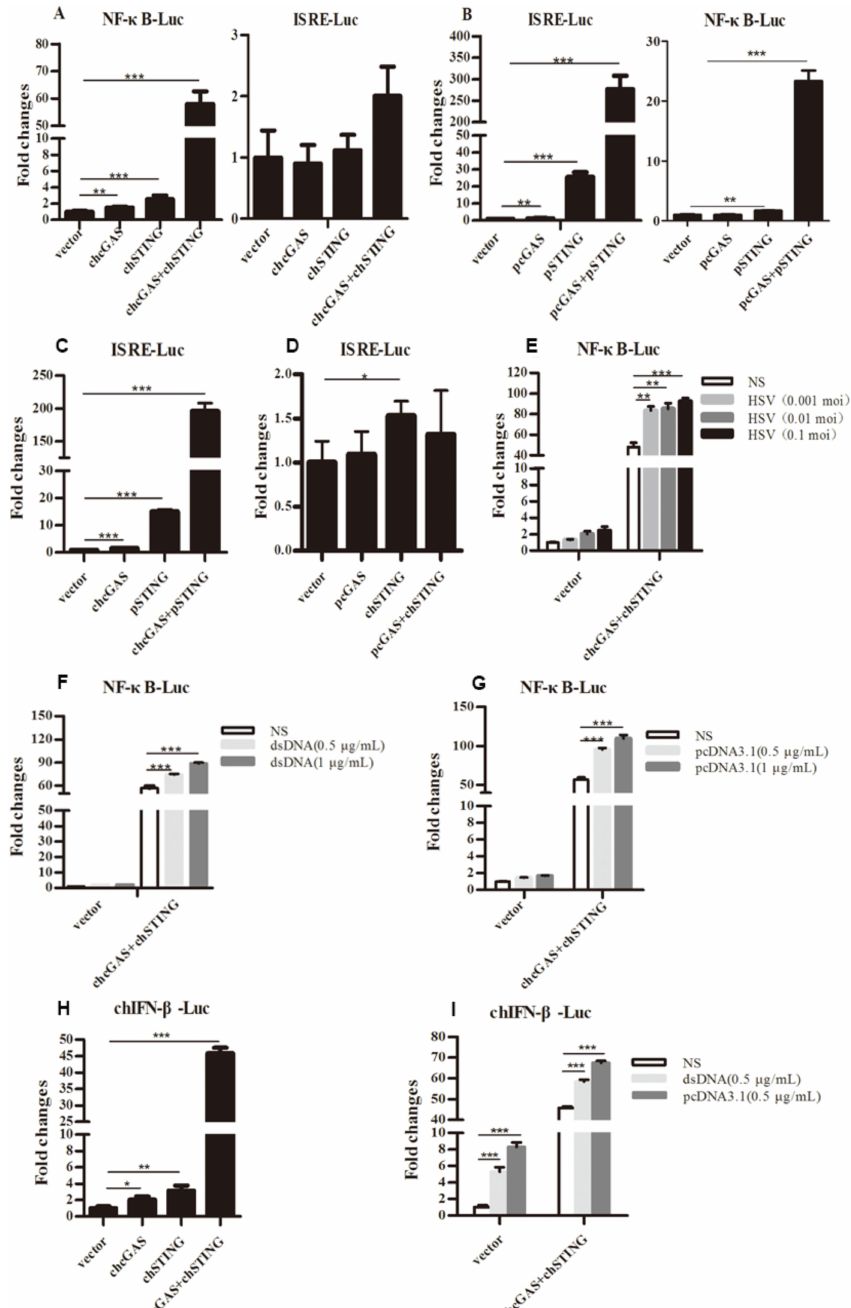
Figure 2. Promoter activation by chcGAS and chSTING. ( A–D ) 293T cells grown in 96-well plates (3 × 10 4 cells / well) were transfected with chcGAS / pcGAS (20 ng), chSTING / pSTING (10 ng) plus ISRE-Fluc / ELAM-Fluc (10 ng) and Rluc (0.2 ng), which were normalized to 50 ng / well using the lipofectamine 2000. Twenty-four hours post transfection, the luciferase activities were measured with Double-Luciferase Reporter Assay. ( E–G ) 293T cells were transfected as in ( A–D ) and 24 h later were infected with HSV-1 or stimulated with dsDNA and pcDNA3.1 by transfection with the indicated concentrations. Eight to Twelve hours post stimulation, the luciferase activities were measured. ( H , I ) HD11 cells in 96-well plates were transfected as above with chIFN β Fluc reporter using TransIT-LT1 Transfection Reagent, and 24 h later stimulated with dsDNA and pcDNA3.1 by transfection. Eight to Twelve hours post stimulation, luciferase activities were measured. The signs “*”, “**”, “***” denote p < 0.05, p < 0.01 and p < 0.001,